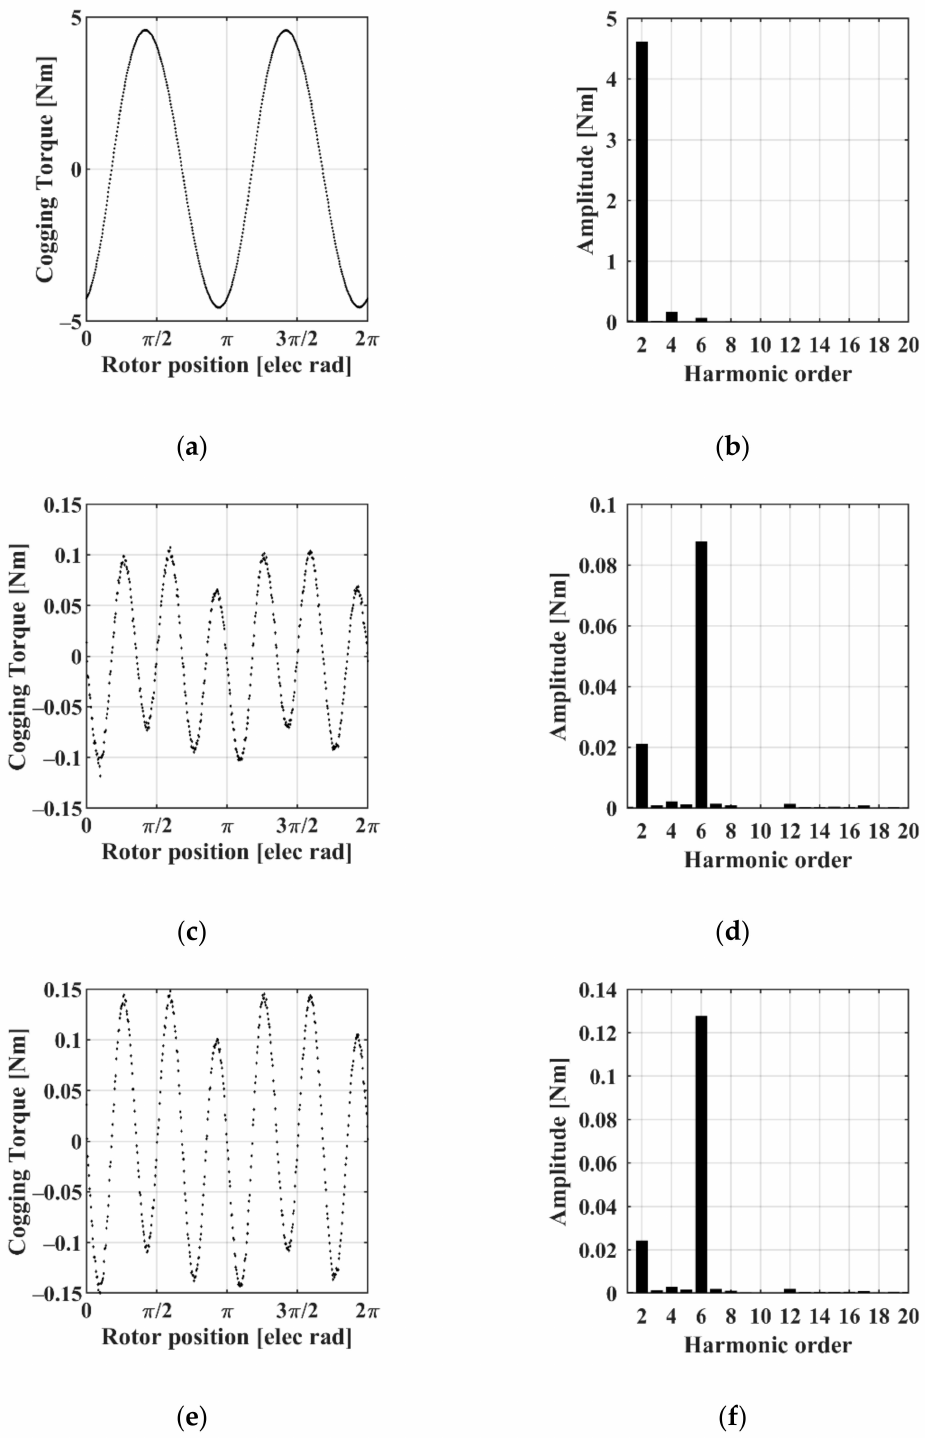
Figure 3. Cogging torque waveforms and harmonic spectra of the APMMs: ( a , b ) APMM with 20 stator segments; ( c , d ) APMM with 30 stator segments; ( e , f ) APMM with 60 stator